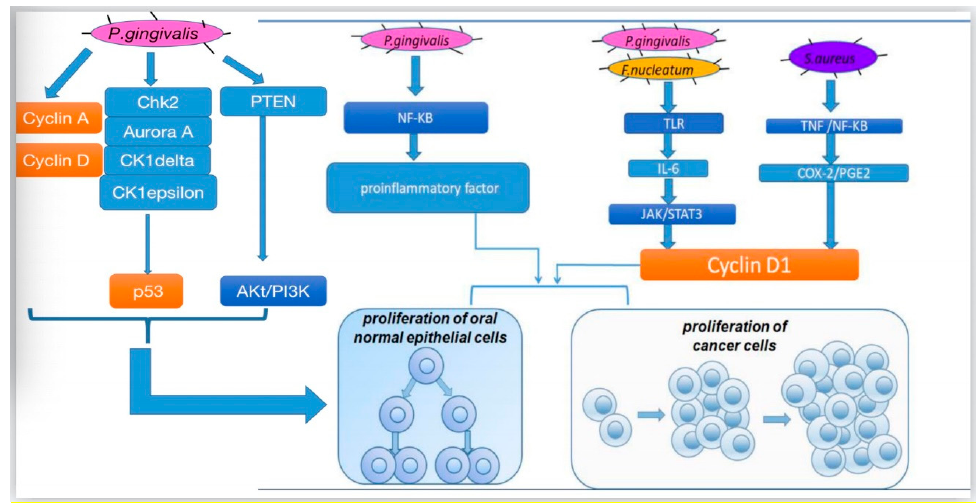
Figure 1. Mechanisms for how oral bacteria promote cell proliferation.